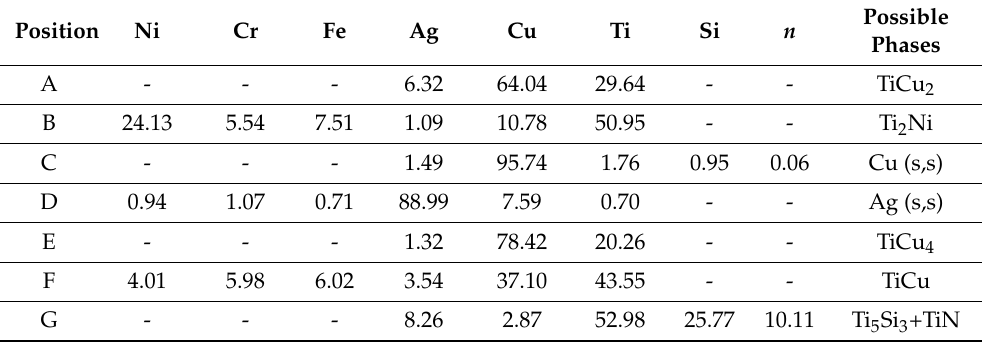
Table 2. EDS results for the chemical composition of the different phases in Figure 4 (at. %). Position Ni Cr